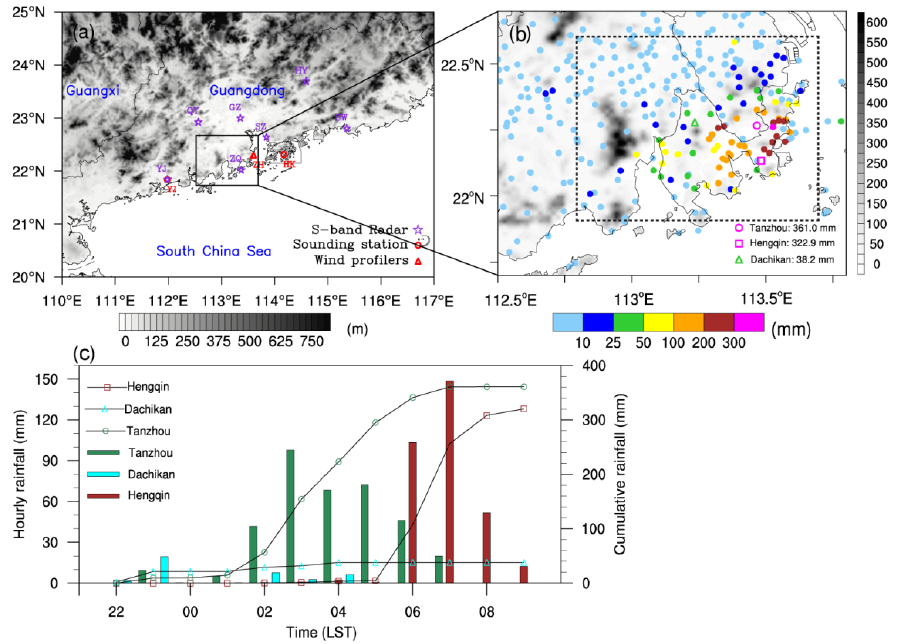
Figure 1. ( a ) Locations of seven dual ‐ polarization radars in South China (purple star denotes the location of radar) and terrain height (shaded, units: m). The red circle denotes the sounding at Yangjiang (YJ) and Hong Kong (HK). The red triangles denote the wind profiling radar at Zhuhai (ZH). The solid black box shows ( b ) area. ( b ) 12 ‐ h precipitation from 2200 LST on 31 May 2021 (colored dots; unit: mm) observed by AWSs. Terrain is shaded in gray. The black dashed box is the key area in this study, which contained most of the heavy ‐ precipitation stations in the HRE. ( c ) Hourly precipitation (mm) at Henqing, Tanzhou, and Dachikan stations and cumulative precipita- tion (broken line, right